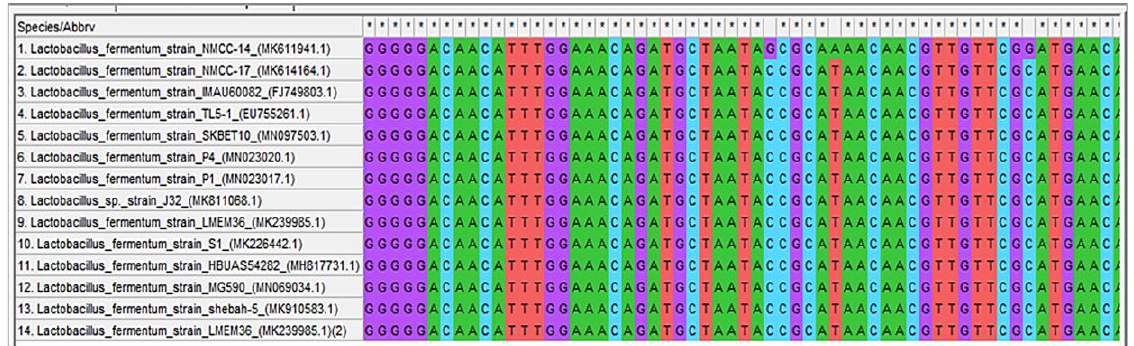
Figure 9. Blast results shows similarity to Lactobacillus fermentum.